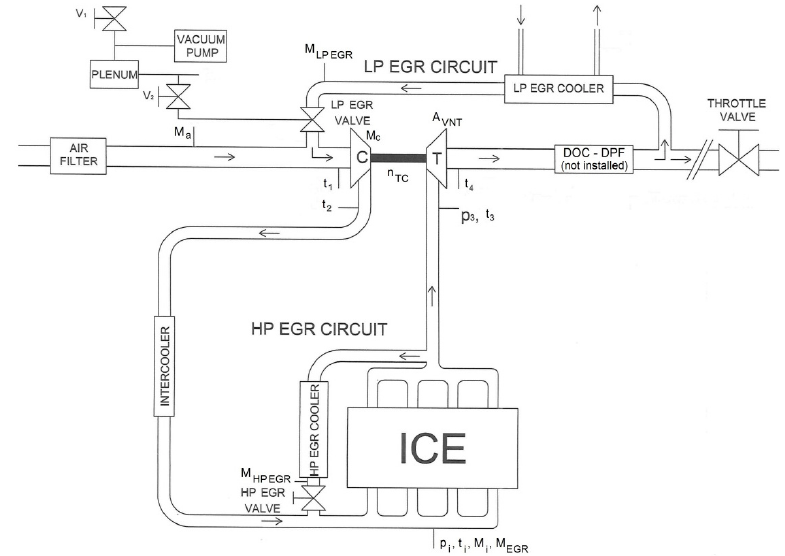
Figure 1. Hybrid EGR system layout. LP: low pressure; VNT: variable nozzle turbine; DOC: diesel oxidation catalyst; DPF: diesel particulate filter; and ICE: internal combustion engine.